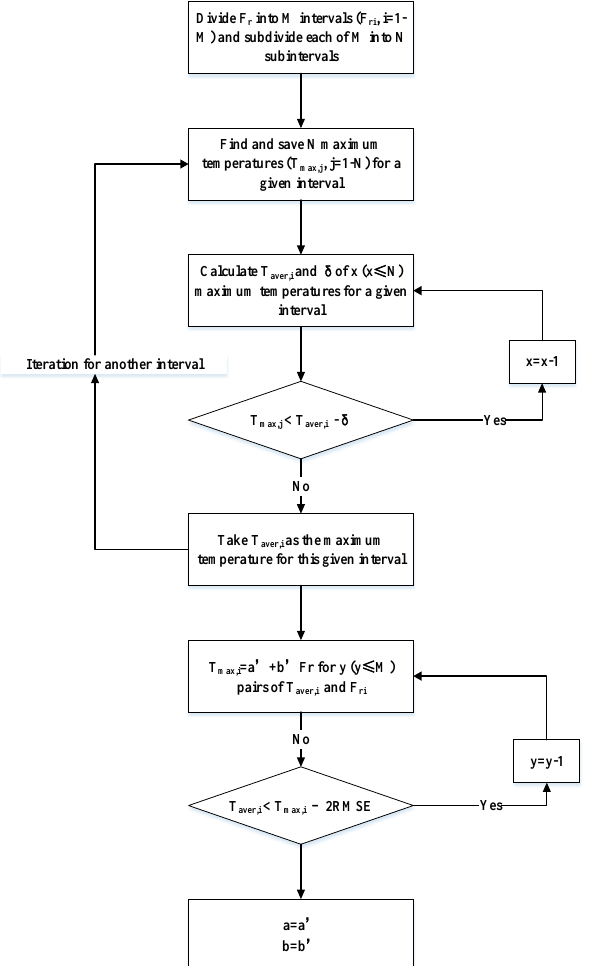
Figure 3. Flow chart of the algorithm of the proposed dry edge determination in the Ts–VI triangle space, where F r is the fraction of vegetation; T aver is the average value, and δ is the standard deviation of the N maximum surface temperatures (referring to Tang et al. [12]).